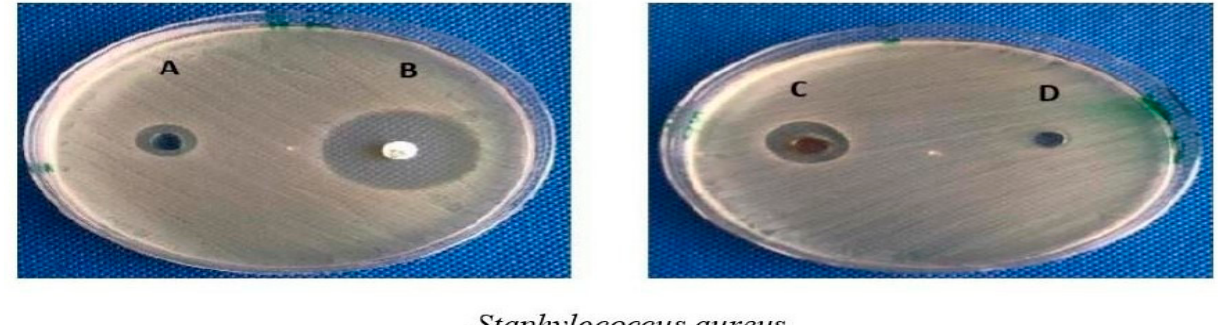
Figure 10. Antibacterial activity of A—red currant aqueous extract; B—antibiotic (Gentamycin-30 µ g); C—red currant-AgNPs, D—AgNO 3 against pathogenic bacterial isolates .